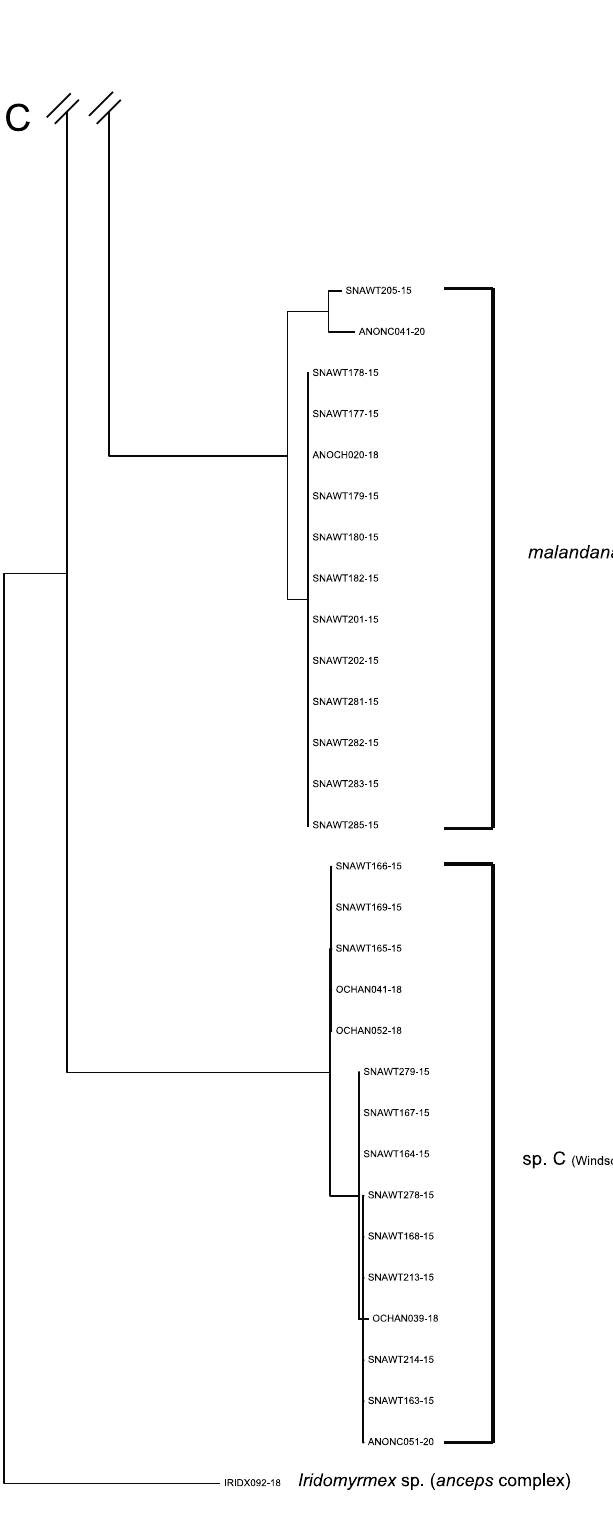
Figure 3. ( A – C ) Maximum likelihood CO1 tree of 97 specimens of Anonychomyrma from the Australian Wet Tropics, with a specimen of the anceps complex of Iridomyrmex as an outgroup.